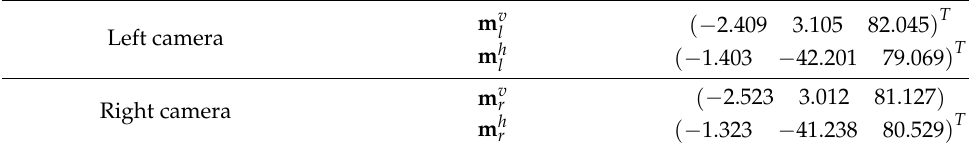
Table 3. Rotation radius vector of left and right cameras.